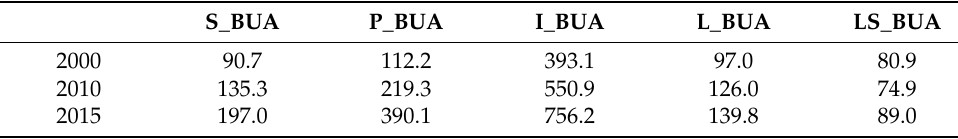
Figure 9. The scatter plot of LS_BUA and built-up area statistics in ( a ) 2000, ( b ) 2010, and ( c ) 2015. Table 5. The RMSE values of built-up area data (km 2 ).